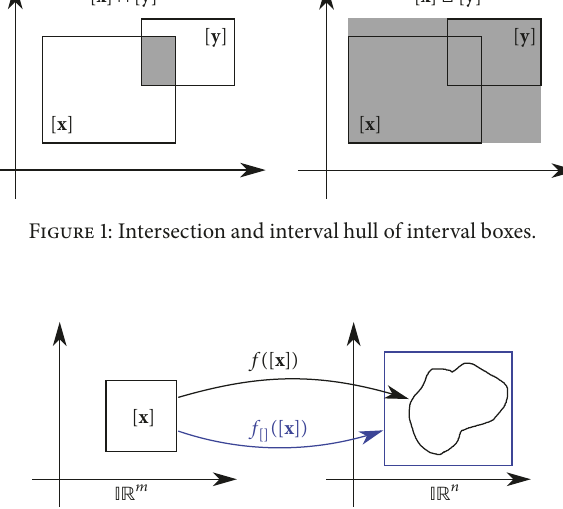
Figure 2: Images of an interval box by function 𝑓 and its inclusion function 𝑓 [] .